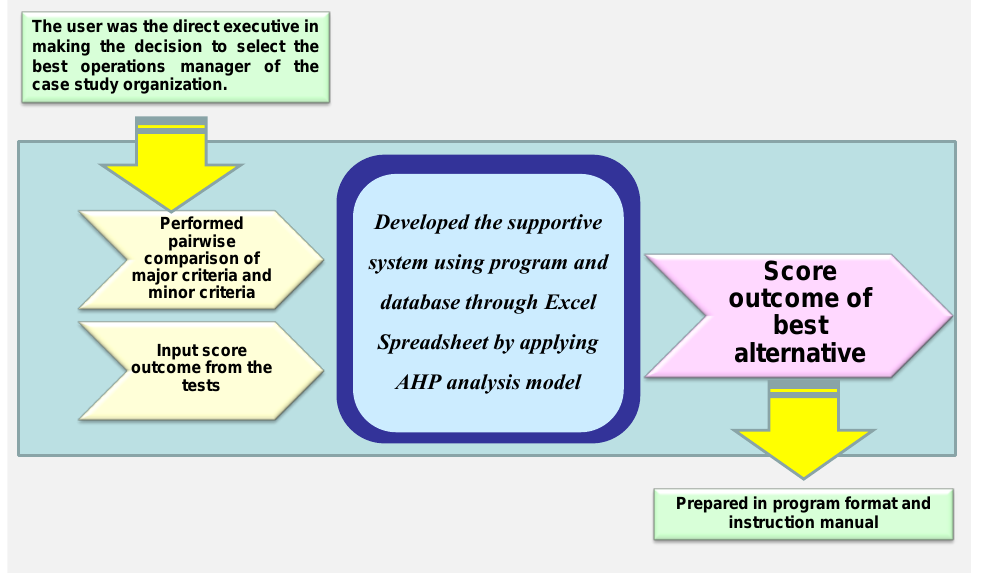
Fig. 7. Decision support system for selecting a shop operations